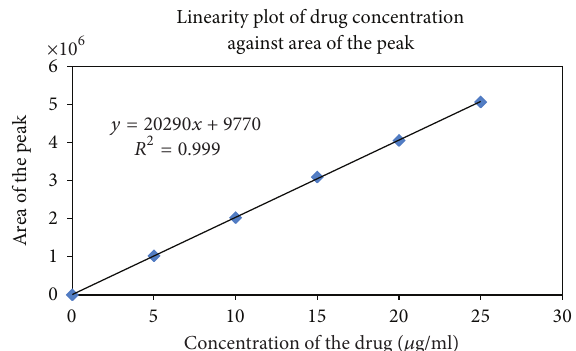
F 2: Linearity of the drug concentration against the area of the